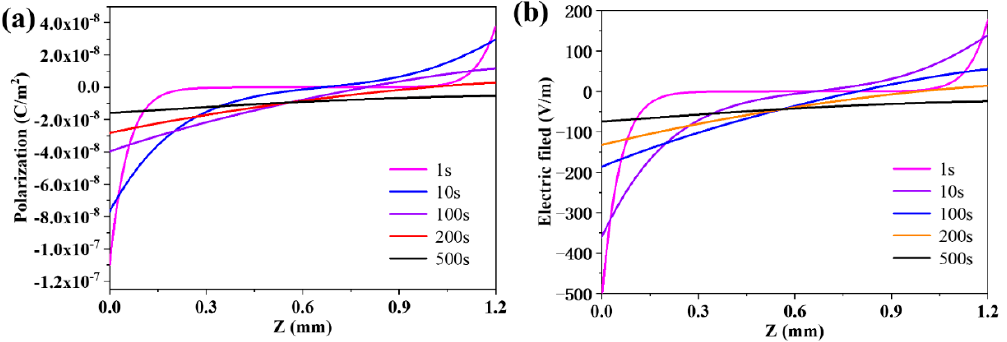
Figure 4. ( a ) The evolution of polarization in the membrane; and ( b ) the evolution of electric field in the membrane. the membrane.